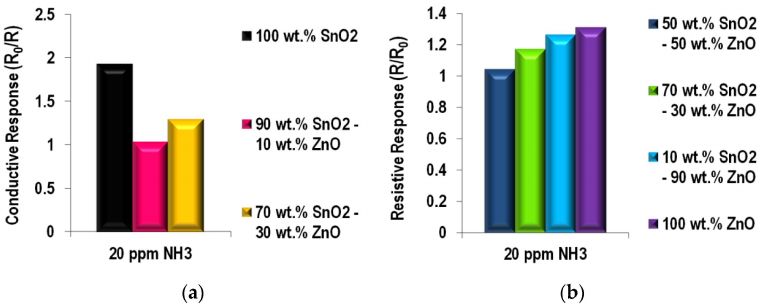
Figure 9. ( a ) Conductive responses and ( b ) resistive responses of the SnO 2 -ZnO array against 20 ppm NH 3 at an operating temperature of 300 ˝